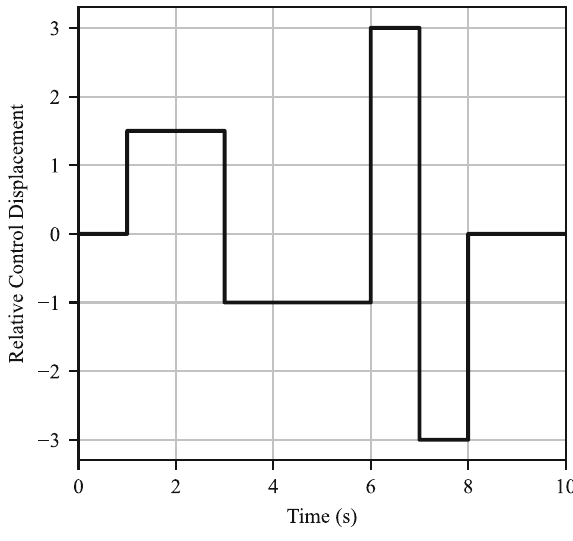
Fig. 3 Typical 2-3-1-1 control